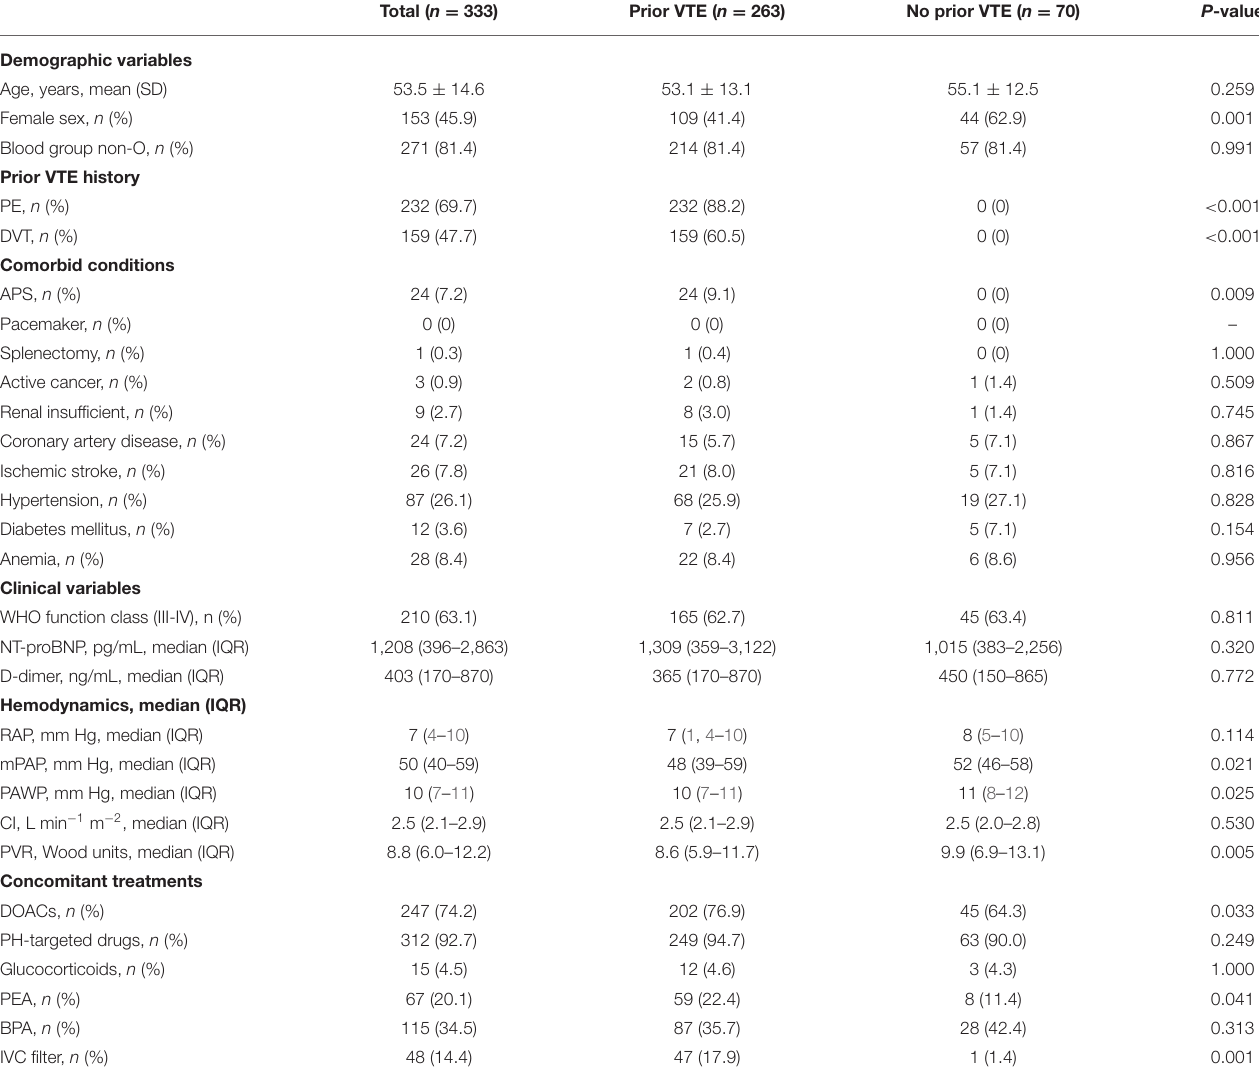
TABLE 1 | Demographic and clinical characteristics of included CTEPH